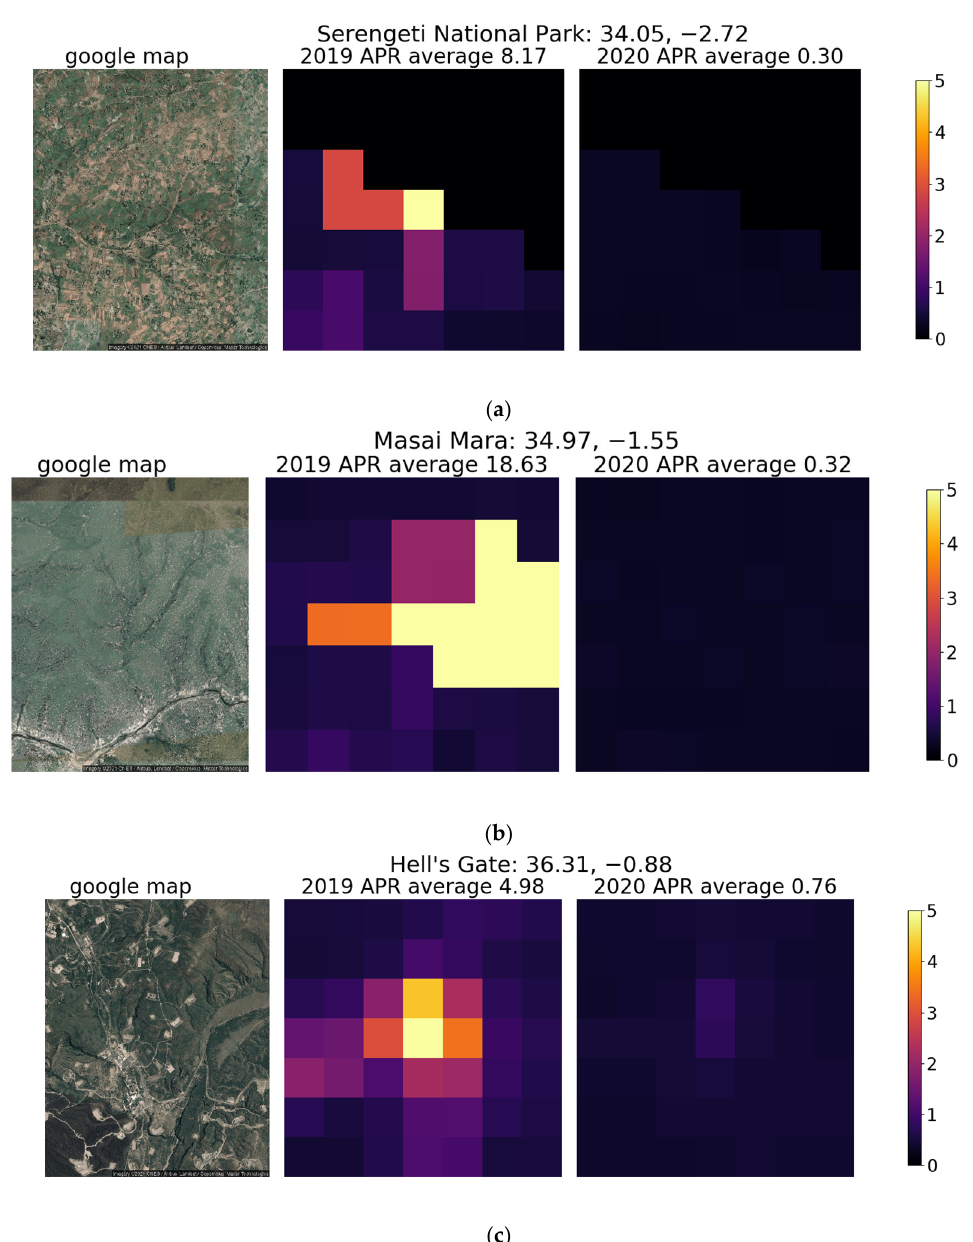
Figure 8. On the left part of each panel, satellite images show the popular tourist lodges, camp settlements, and markets around the three parks. The NTL data for these same sites, showing before (in the middle part of each panel) and after (right part of each panel), indicate that the locations have undergone a decrease in the light intensity. ( a ) Serengeti National Park; ( b ) Masai Mara; ( c ) Hell’s Gate National Park.